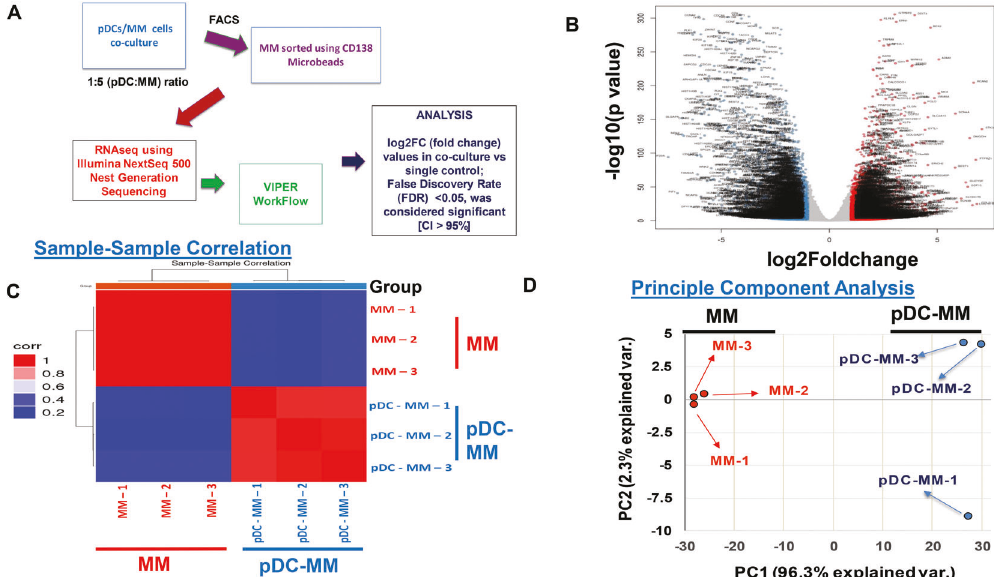
Fig. 1 RNAseq analysis of MM cells in the presence or absence of pDCs. A Schema showing an overview of RNAseq methods and bioinformatics analysis. Puri fi ed MM patient pDCs (from three MM patients) were co-cultured with MM.1S cells (1pDC:5MM) for 48 h, followed by separation of MM.1S cells from pDCs using fl ow cytometry. Total RNA from MM.1S cells was subjected to RNAseq analysis using Illumina NGS. Raw sequence data were analyzed using VIPER work fl ow generating differential expression (DEseq2) and KEGG pathway [27, 28]. Statistical signi fi cance: log2FC (fold change) values in coculture vs control, with an FDR false discovery rate value of <0.05, was considered signi fi cant (CI > 95). Linear model for RNAseq analysis (Limma) and its GUI (Glimma) were also utilized for the visualization of data. B – D pDCs trigger genetic alterations in MM cells. Quantitative analysis demonstrated upregulation or downregulation of genes in MM cells after coculture with pDCs (log2FC range: ±6.0). MM.1S cells were co-cultured with pDCs (from three MM patients) for 48 h (in triplicate, n = 3); separated using CD138 antibody by fl ow sorting, and harvested. Poly RNA was subjected to RNAseq analysis using Illumina NextSeq 500 NGS for total RNA. A total of 19,569 and 25,436 transcripts were analyzed through negative binomial (DEseq2) and linear (Limma) models, respectively. We found that ~9200 (47.01%) and 9250 (36.36%) genes, respectively, were differentially upregulated or downregulated ( p < 0.05). B Volcano Scatter plot showing RNAseq data for MM.1S alone versus coculture. The expression given in log 2 FC varies from ±6 log fold change is >1 (log2FC > 1). Genes are colored blue if the log2 fold change is < − 1 (log2FC < − 1). C Sample – Sample correlation for MM.1S cells cultured in the presence (pDC-MM or coculture; sample names: pDC-MM-1, pDC-MM-2, and pDC-MM-3) vs absence (MM; sample names: MM- 1, MM-2, and MM-3) of pDCs is shown. The correlation clustering shows that MM and pDC-MM are clustered in two different groups based upon differential gene expression. D Principal component analysis (PCA) showing pDC-induced genetic changes in MM cells: high dimensional expression data was mathematically reduced to principal components that were used to describe variation across samples in fewer dimensions to allow logical interpretation. Principal component 1 (PC1) accounts for the most amount variation across samples, followed by PC2. The PC1 vs PC2 plot of the RNAseq data is presented showing two sets of samples (MM and pDC-MM) clustered in spatially separated groups in reduced dimensional space, implicating a distinct genetic status of MM cells when cultured alone (MM) versus with pDCs